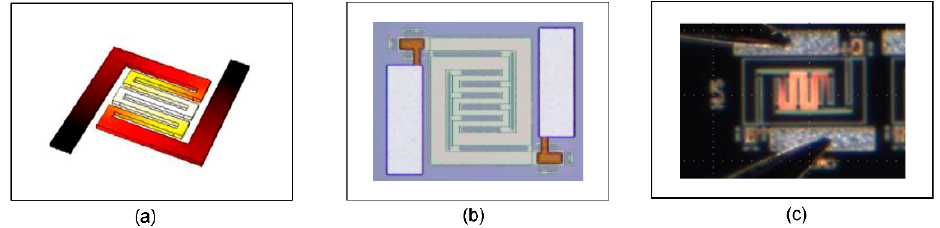
Figure 1. ( a ) FEM analysis of heat distribution within emitter structure, ( b ) optical image of produced device, ( c ) IR-Emitter at operation mode.